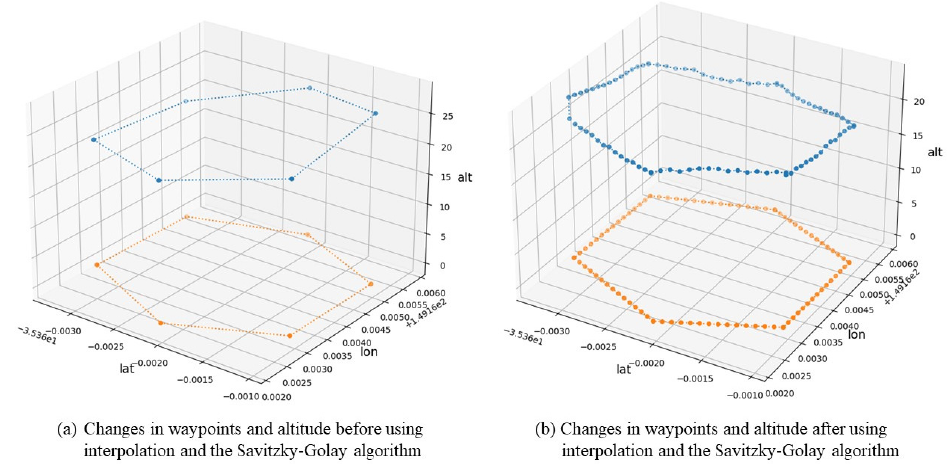
Figure 5. Changes in waypoints before and after using interpolation and the Savitzky-Golay algorithm.